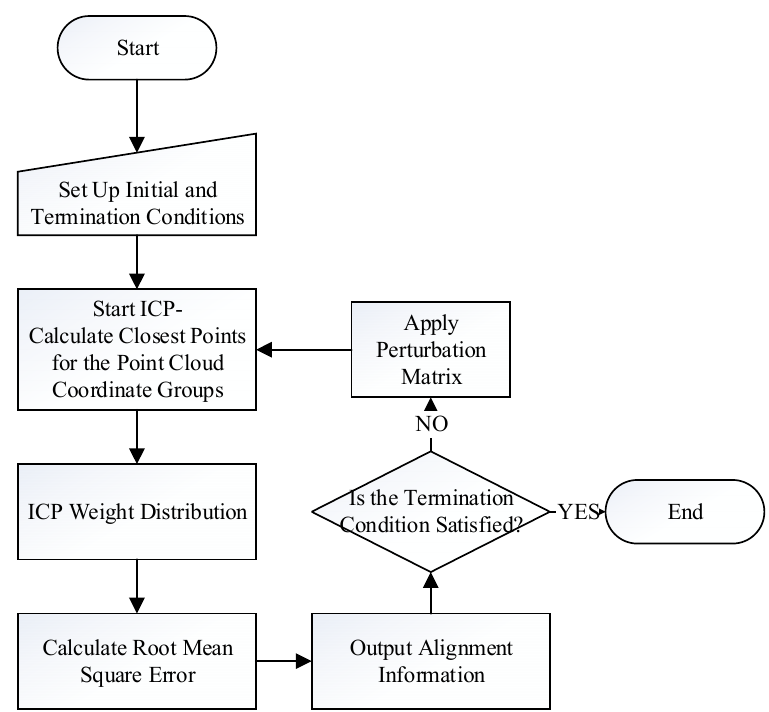
Figure 5. The five-point facial feature points used in face detection. The Max-Margin Object Detection (MMOD) algorithm is a maximum edge object detector, based on the Convolutional Neural Network (CNN), and can help solve the problem which occurs when the observer is so far away from the camera that the features cannot be correctly identified. Once the feature points are identified, the center between the two eyes is set as the position of the observer. Once the position of the observer is